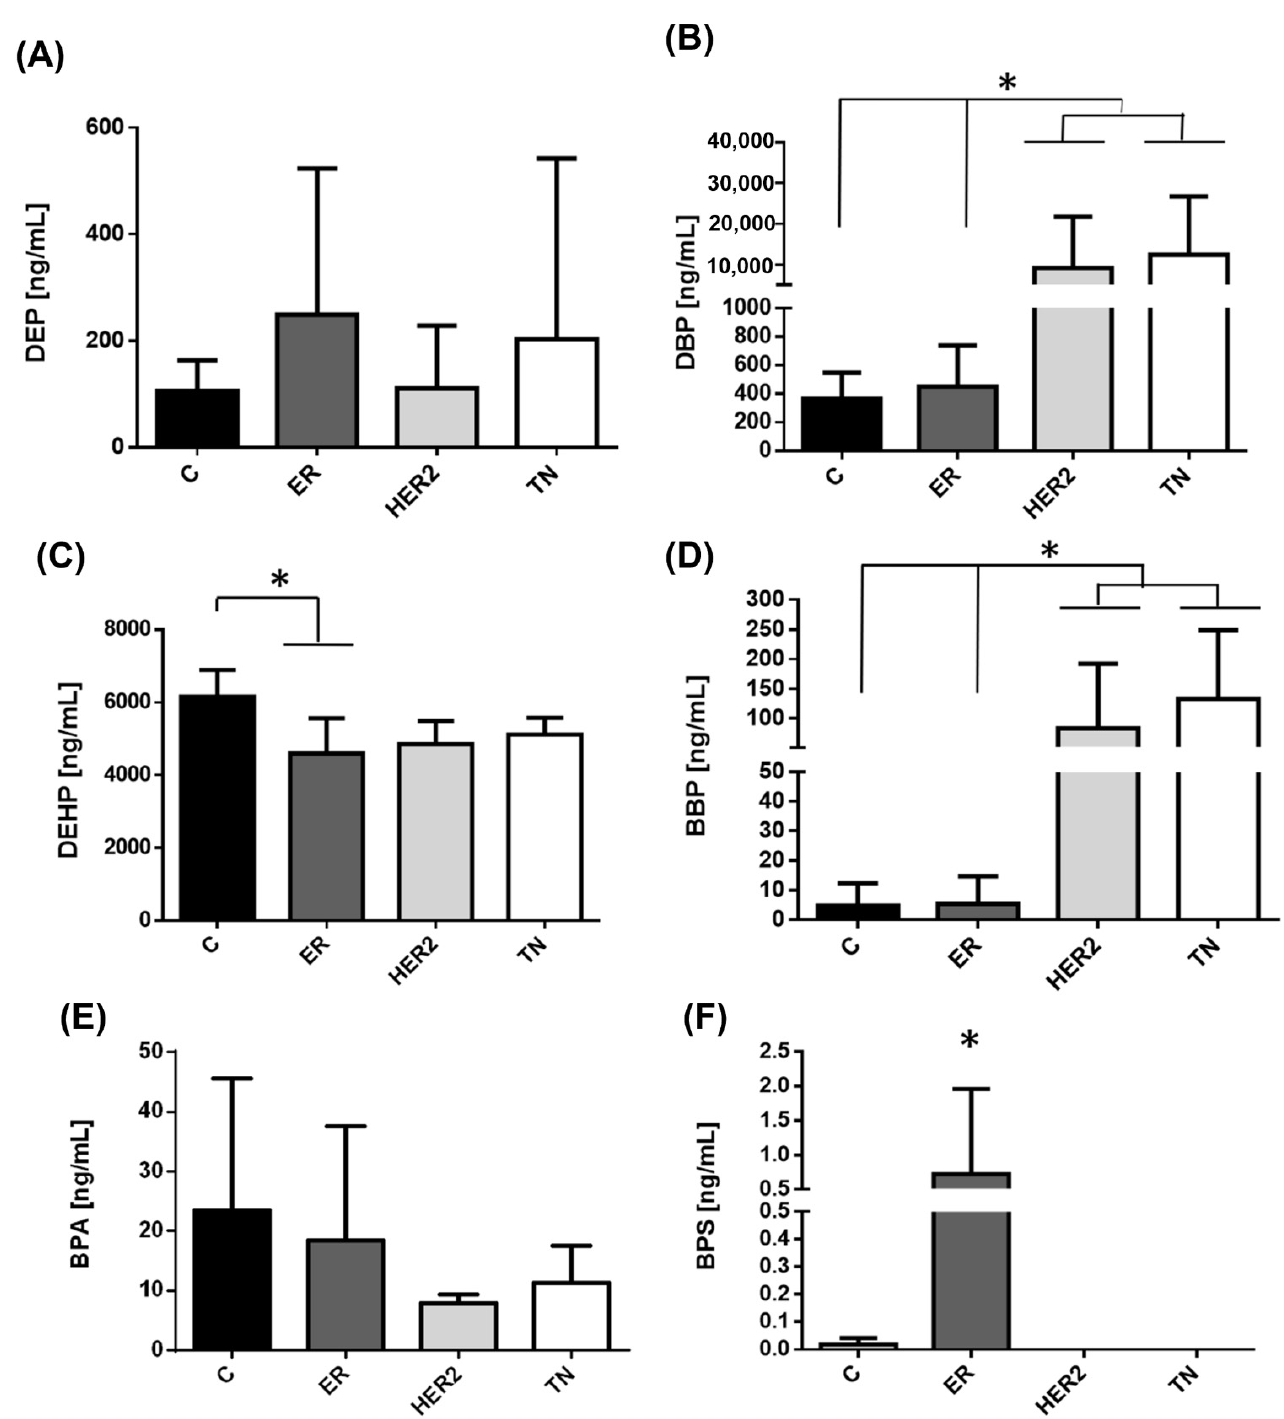
Figure 4. Levels of phthalates in patients with BC divided by molecular phenotype in Mexico City. Serum concentration levels of phthalates measured in different BC subtypes from Mexico City. The image displays the different serum concentrations of ( A ) DEP, ( B ) DBP, ( C ) DEHP, ( D ) BBP, ( E ) BPA, and ( F ) BPS in the control group (C/13 subjects, black bar) and compared with patients with BC divided by molecular phenotype; (ER+/4 subjects/dark gray bar; HER2+/4 subjects light gray bar, and TN/6 subjects, white bar). Bars represent the mean ± S.D. * p < 0.05 was considered statistically